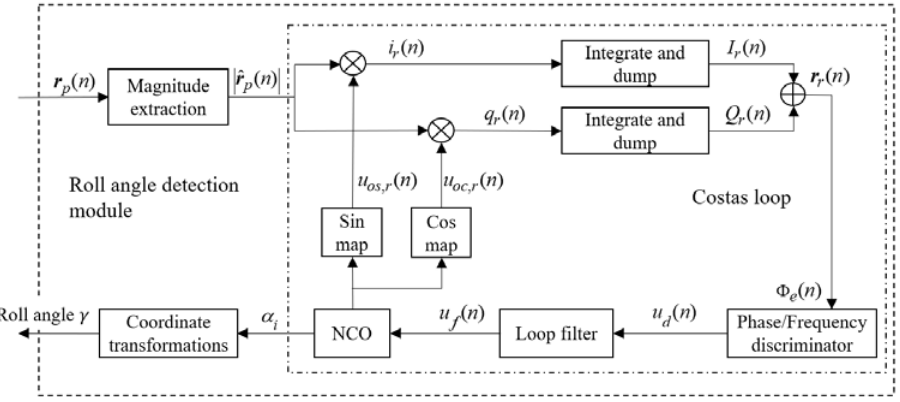
Figure 9. Block diagram of the proposed roll angle detection module.